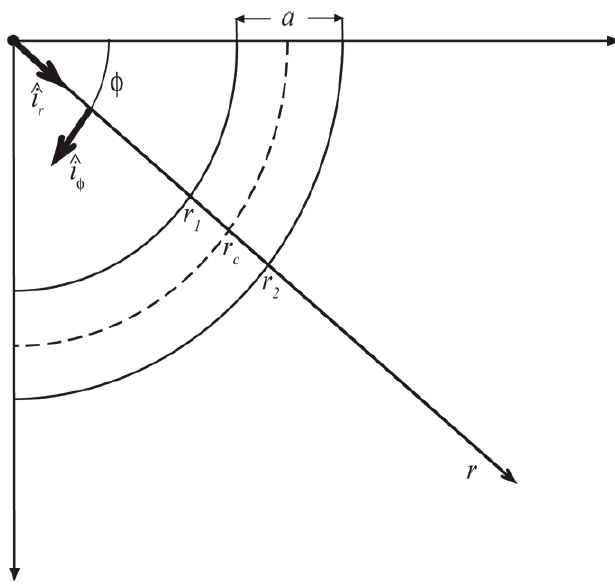
Figure 11. Sketch of the model for bends and the coordinate system.